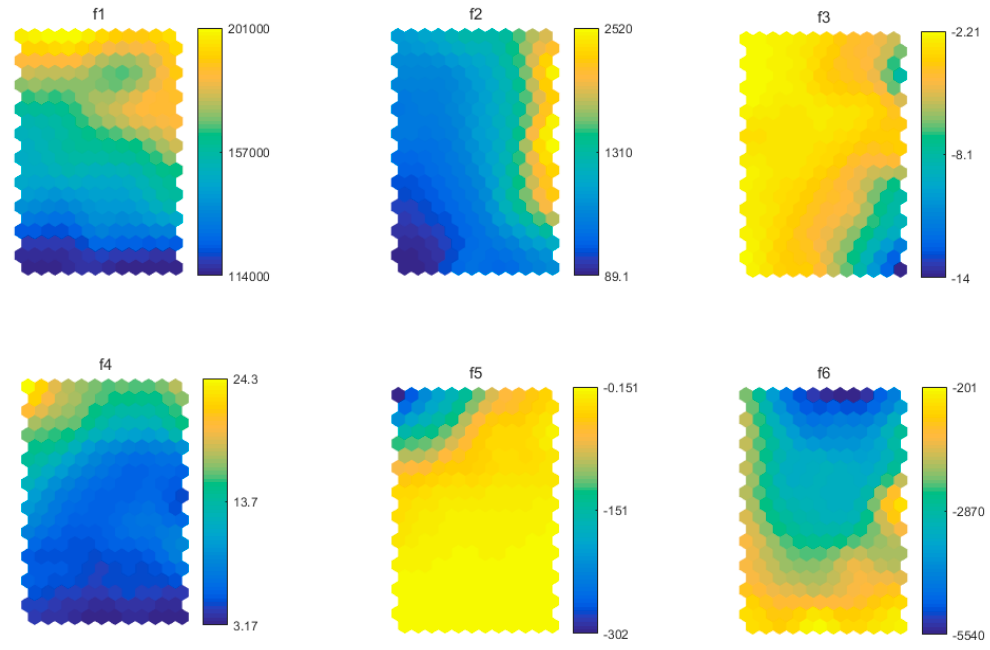
Figure 16. Self-organizing maps (SOMs) generated for the set of Pareto optimal solutions obtained. Appl. Sci. 2019 , 9 , x FOR PEER REVIEW